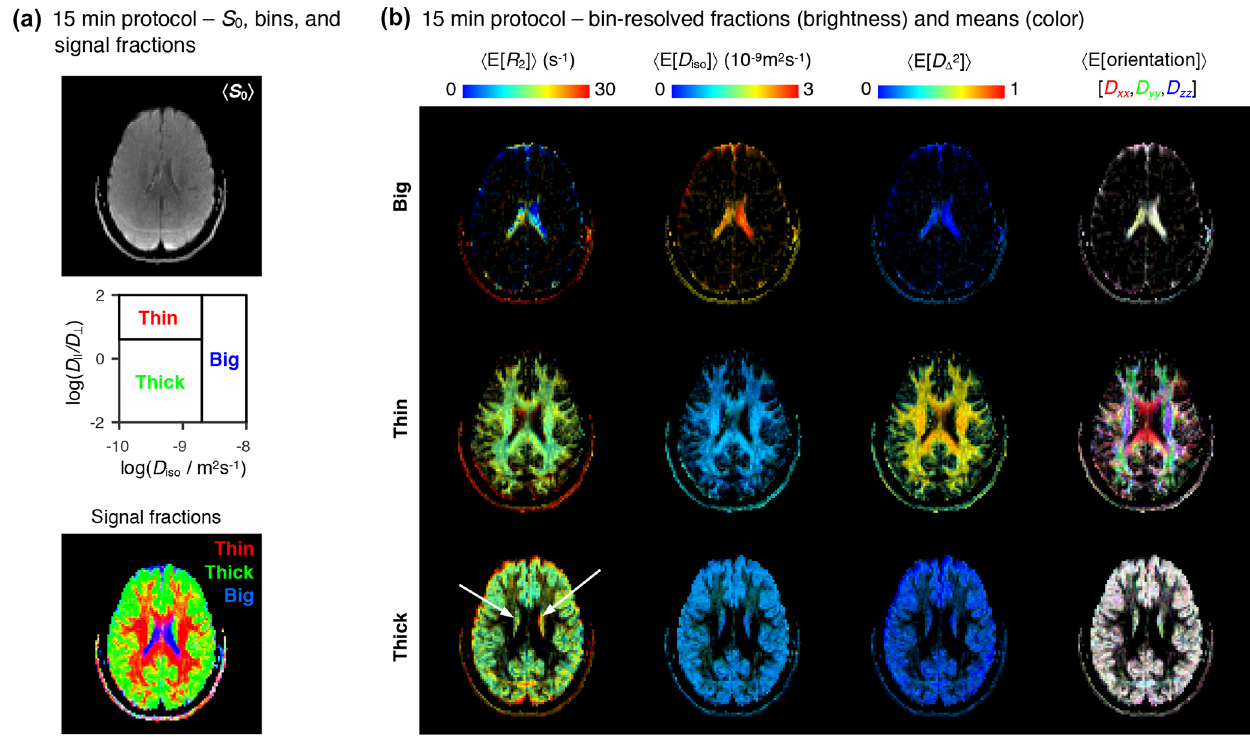
Figure 7. 15min protocol – bin-resolved signal contributions and mean parameter maps. (a) Map of average initial signal intensity (cid:104) S 0 (cid:105) (top); subdivision of the diffusion space into the “big”, “thin”, and “thick” bins (middle); color-coded composite map of per-bin signal contributions (bottom). The colors in the bottom identify the fractions from different bins: [R,G,B] = [thin,thick,big]. (b) Parameter maps of average per-bin means (color) of transverse relaxation rate (cid:104) E [ R 2 ](cid:105) , isotropic diffusivity (cid:104) E [ D iso ](cid:105) , squared anisotropy (cid:104) E [ D (cid:49) 2 ](cid:105) , and diffusion tensor orientation (cid:104) E[Orientation] (cid:105) . The color and brightness of the various maps follows the same convention as Fig.